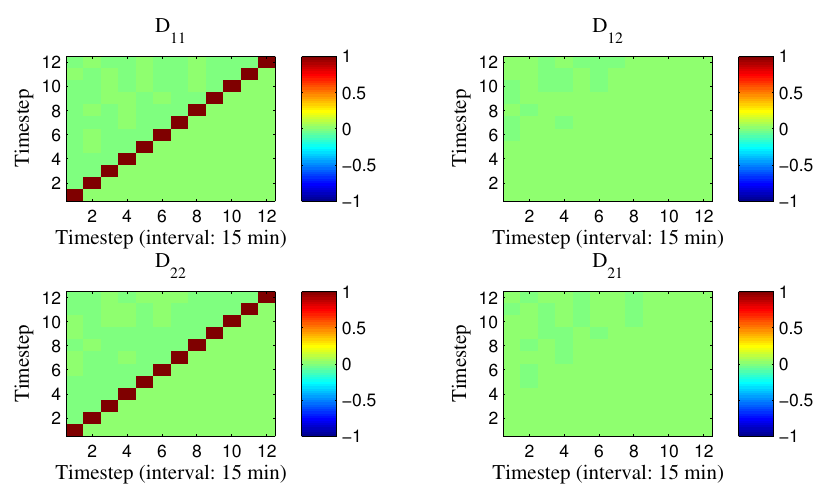
Figure 7. Policy of reserve allocation for three-cell power system in Scenario 1.